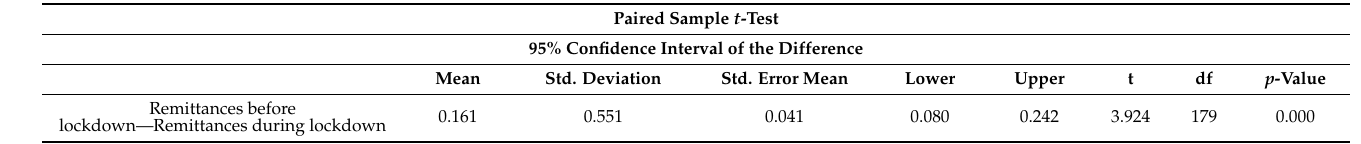
Table 4. Paired Sample t